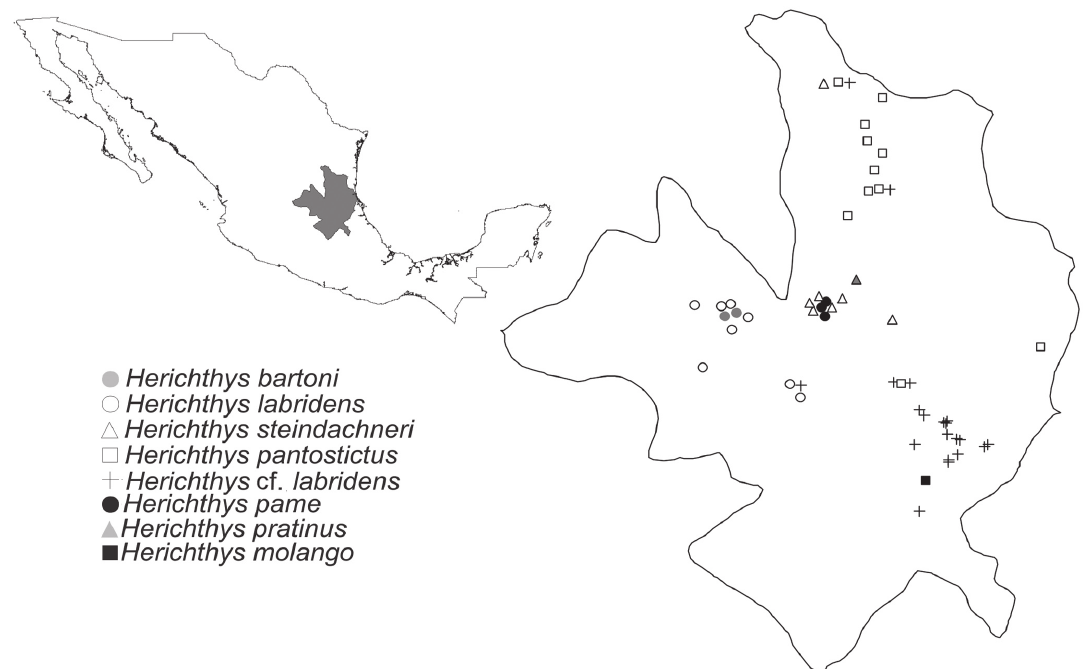
Fig. 1. Geographic distribution of the species included in the Herichthys bartoni group. Note: The species H. pratinus was not included in this